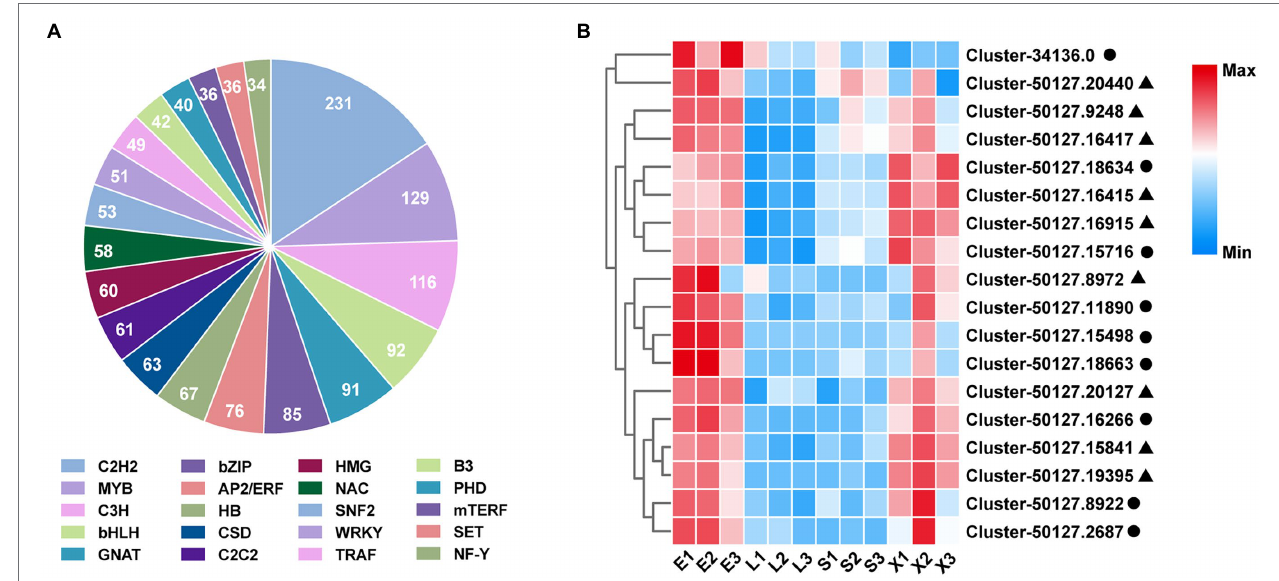
FIGURE 4 | Classification of TF families (A) and expression analysis of bHLH and WRKY family (B) . Closed cycle and triangle represent bHLH and WRKY, respectively. E, epidermis; L, leaf; S, stem; X,